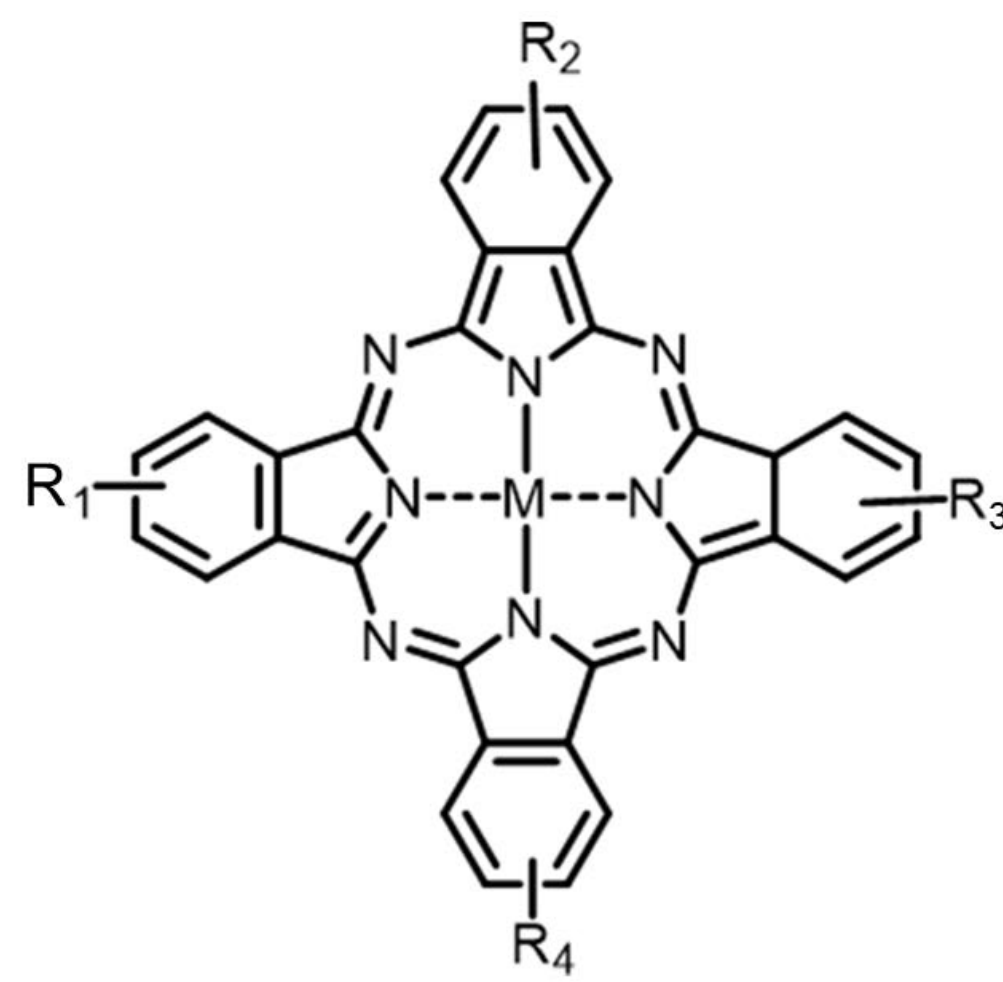
Figure 11. General structure of